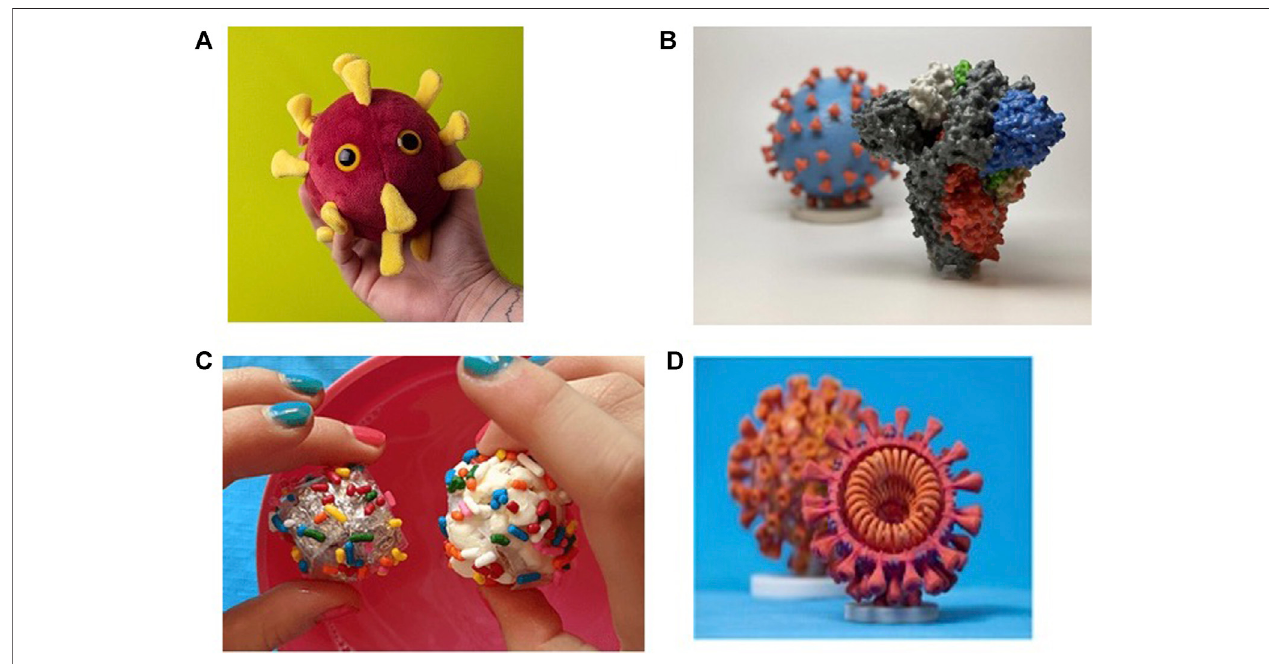
FIGURE 3 | Physical representations (A) Covid-19 plush toy (Firebox, 2021) (B) 3D Covid-19 spike protein (NIAID, 2020) (C) 3D printed model of Covid-19 (Tino et al., 2020) (D) Constructed “ enveloped ” virus model (Slutz, 2020).